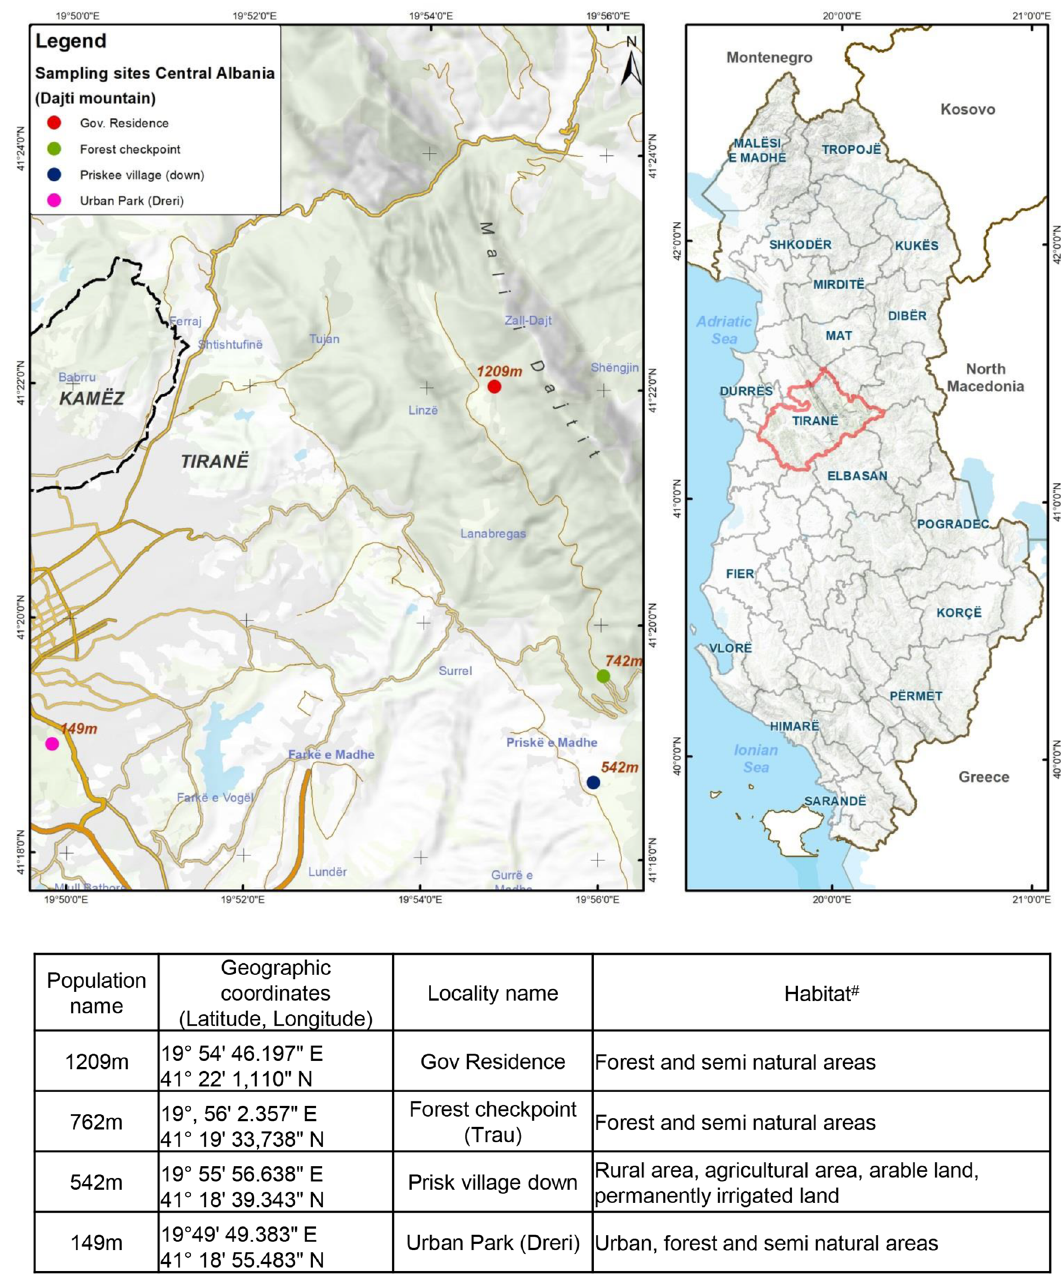
Figure 6. Aedes albopictus populations collected in Albania. Mosquitoes were processed for genotyping with microsatellites and vector competence studies to DENV and CHIKV. The figure was prepared by Eng. Migel Ali, GIS expert at the Company Geo Consulting Albania (https:// gc- al. com/ en/ staff_ mali.